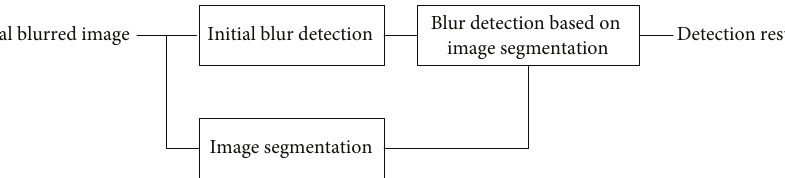
Figure 2: The flow chart of blurred regions